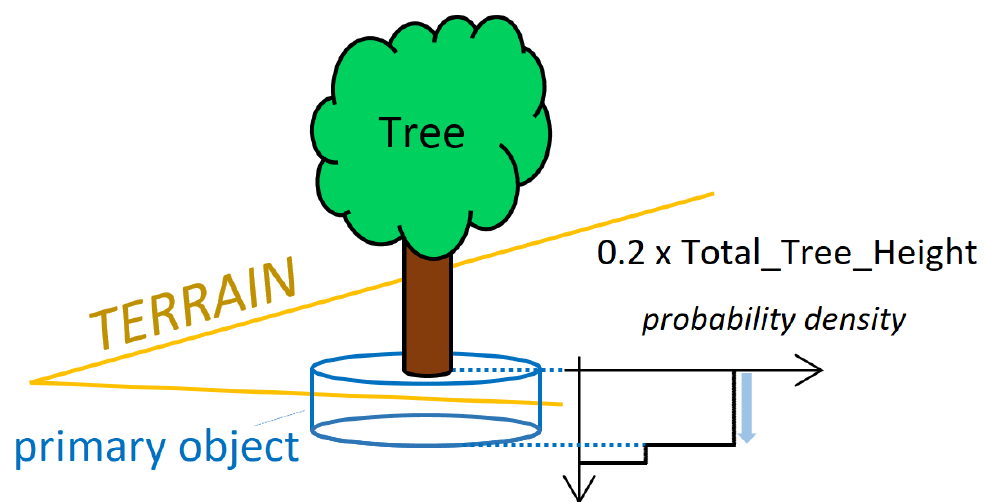
Figure 7. Primary geometry, depth completion and stair type probability density function along the Z-axis.